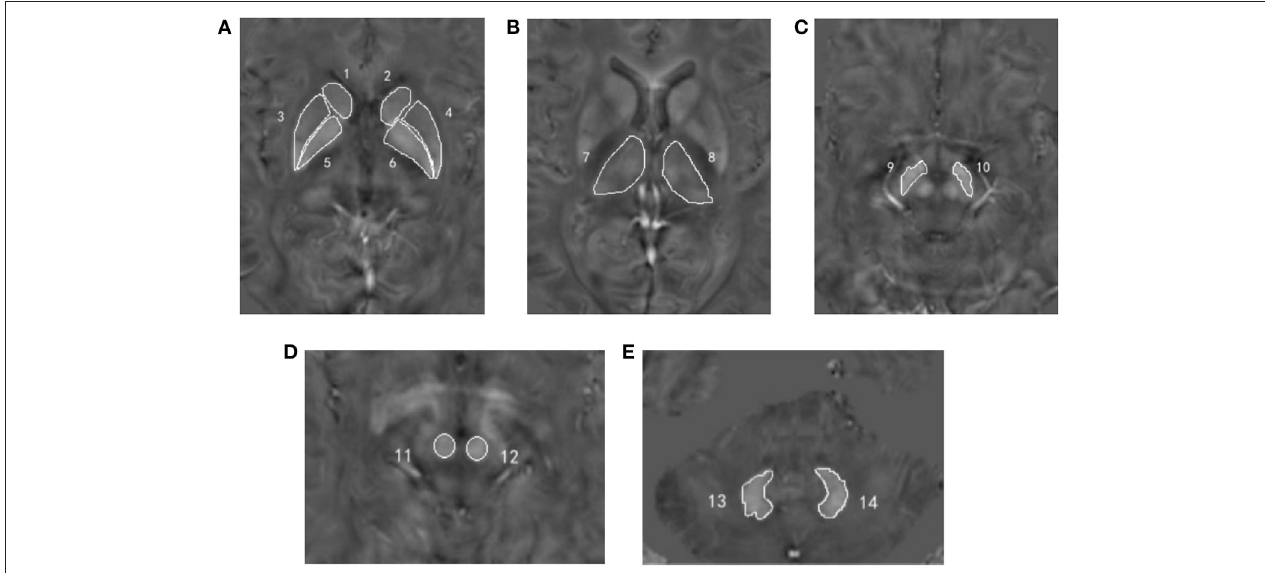
FIGURE 1 | Regions of interest depicted on the quantitative susceptibility mapping images. (A) Number 1, 2 = bilateral caudate nucleus; number 3, 4 = bilateral putamen; number 5, 6 = bilateral globus pallidus; (B) number 7, 8 = bilateral thalamus; (C) number 9, 10 = bilateral substantia nigra; (D) number 11, 12 = bilateral red nucleus; (E) number 13, 14 = bilateral dentate nucleus.